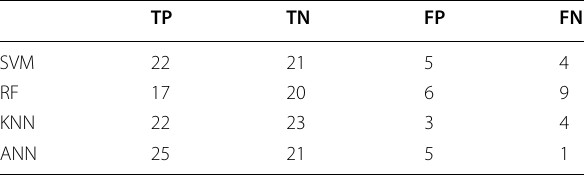
Table 5 Confusion matrix components obtained from each of the classification algorithms based on the properties selected from the structural magnetic resonance images